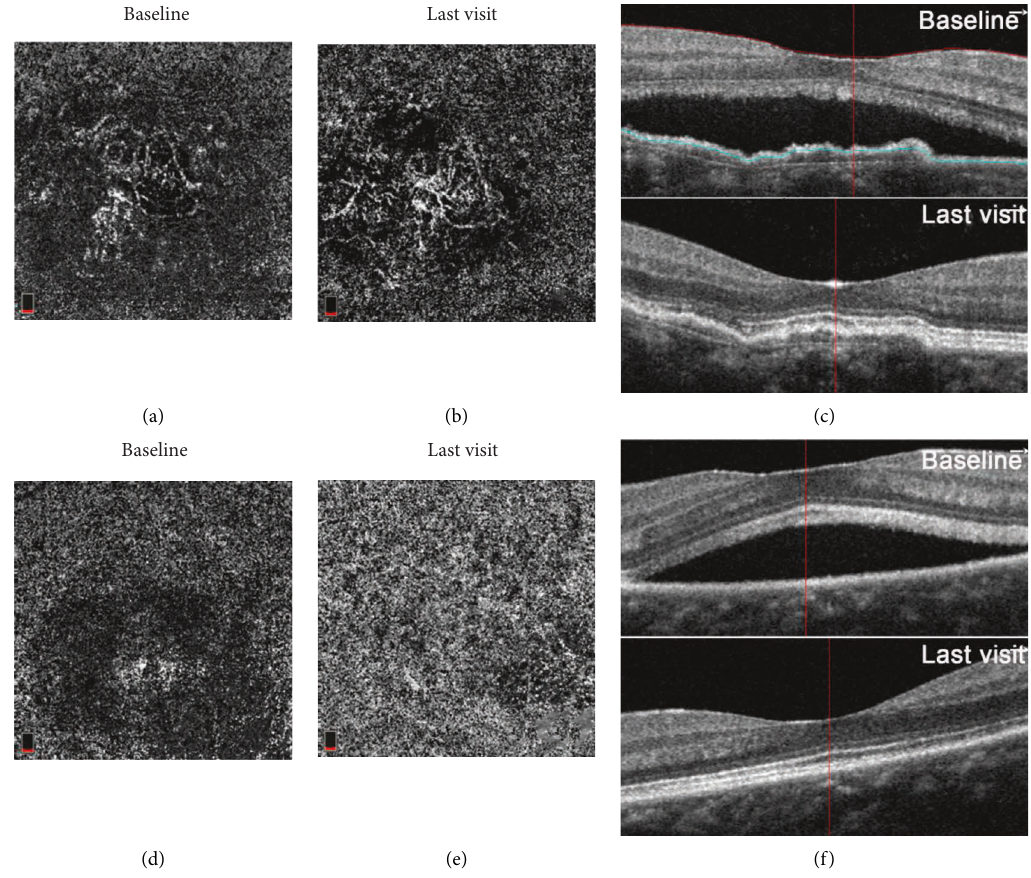
Figure 4: The outcome of both eyes in the same patient after anti-VEGF treatment. (a–c) The right eye. Visible CNV with peripheral anastomosis and dense microvasculature visualized in the choriocapillaris layer on OCTA before (a) and after (b) anti-VEGF treatment, showing vascular remodeling after anti-VEGF treatment. (c) OCTA b-scan showed the resolution of SRF and irregular pigment epithelial detachment (PED) before and after anti-VEGF treatment. (d–f) The left eye. Nonhomogenous hyperreflectivity (putative CNV) in the choriocapillaris layer on OCTA before (d) and after (e) anti-VEGF treatment, showing complete regression of putative CNV after treatment; (f) OCTA b-scan showed complete resolution of SRF after anti-VEGF treatment.